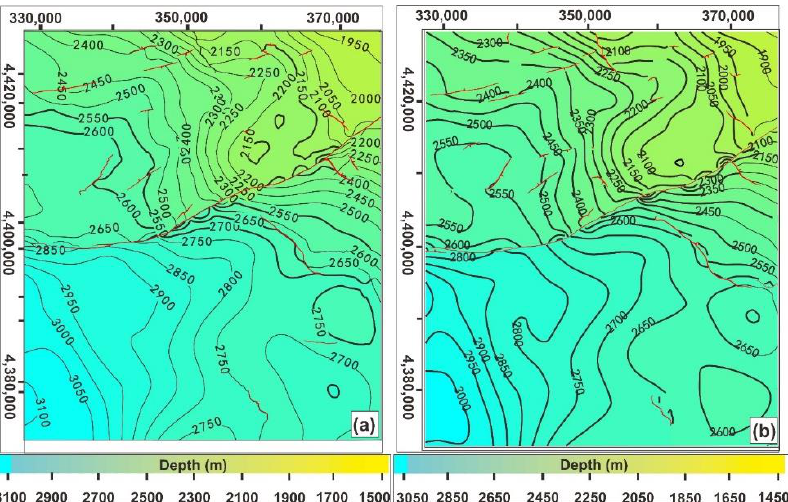
Figure 9. Structural maps show the faults distribution and contour values along horizon slices ( a ) T9d and ( b ) T9e.